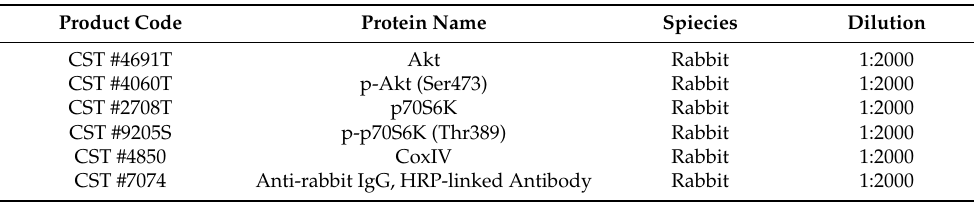
Table 1. List of